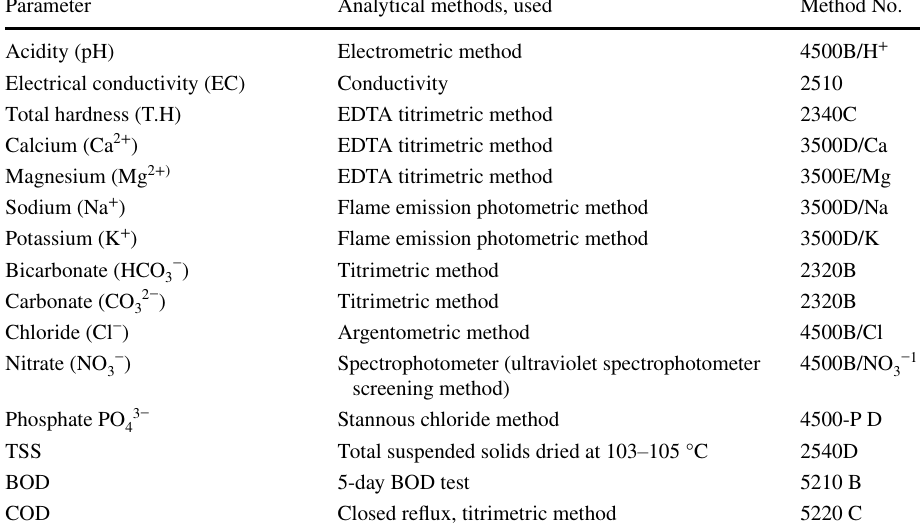
Table 2 Analytical methods used to determine various parameters (APHA